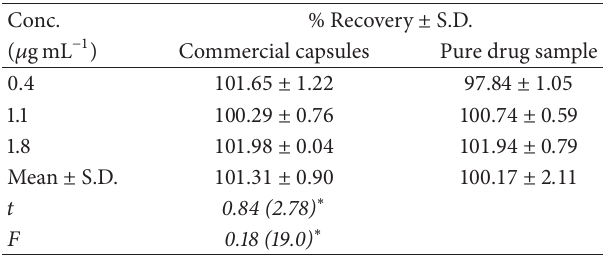
Table 5: Determination of ganciclovir in commercial formulation and statistical comparison with the proposed method. Conc.